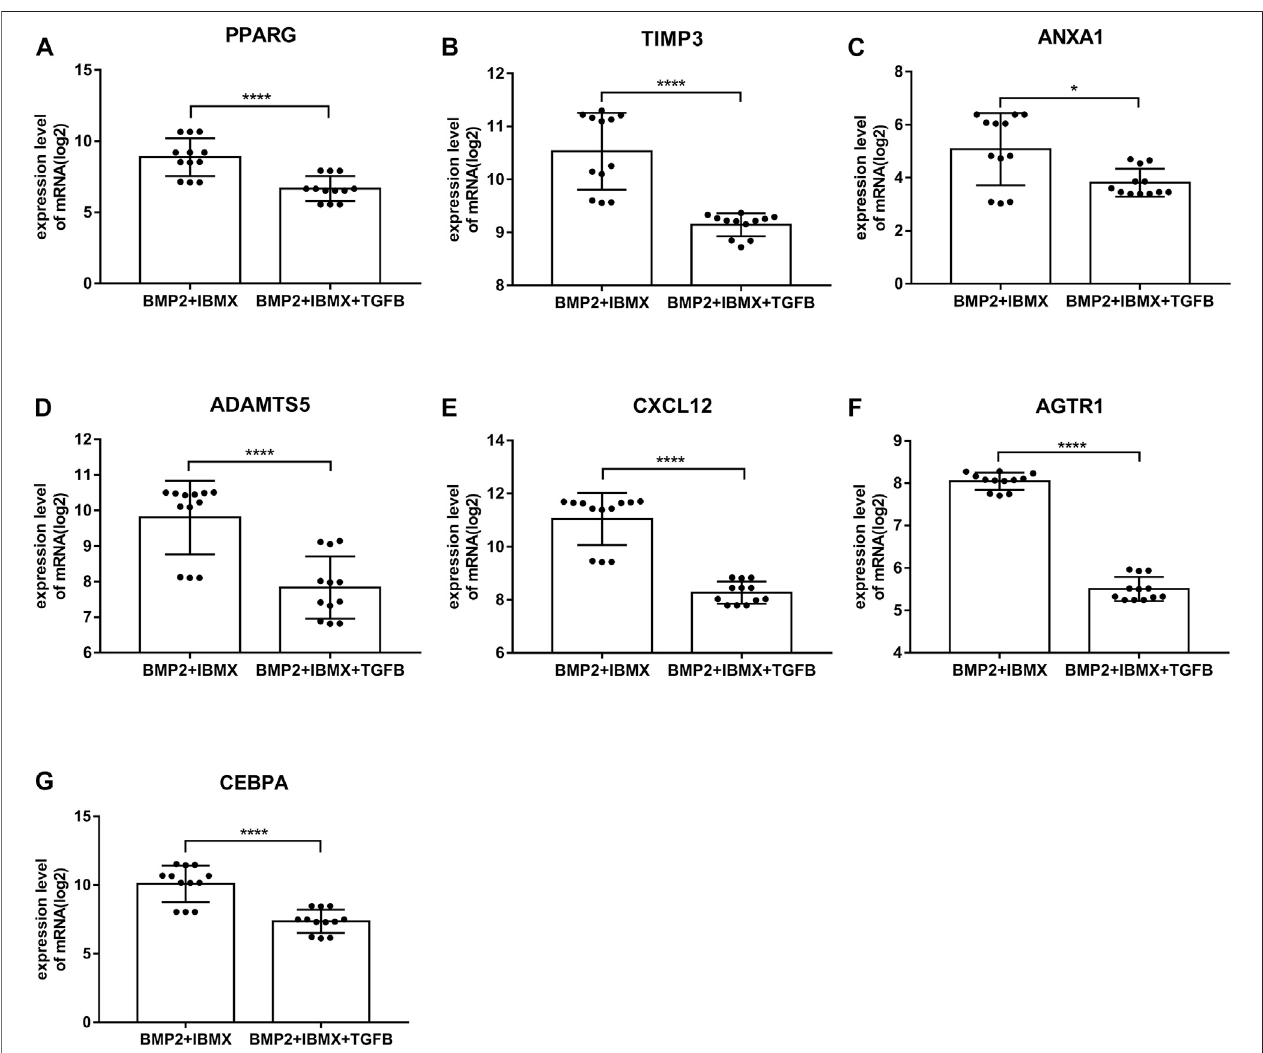
FIGURE 6 | mRNA expression levels of the top seven downregulated hub genes involved in adipogenic differentiation, derived from analysis of 24 samples from four time-points (1, 2, 3, and 7 days; presented on a log2 scale). The data shown are means ± SD. * p < 0.05, ** p < 0.01, *** p < 0.001, **** p < 0.0001.